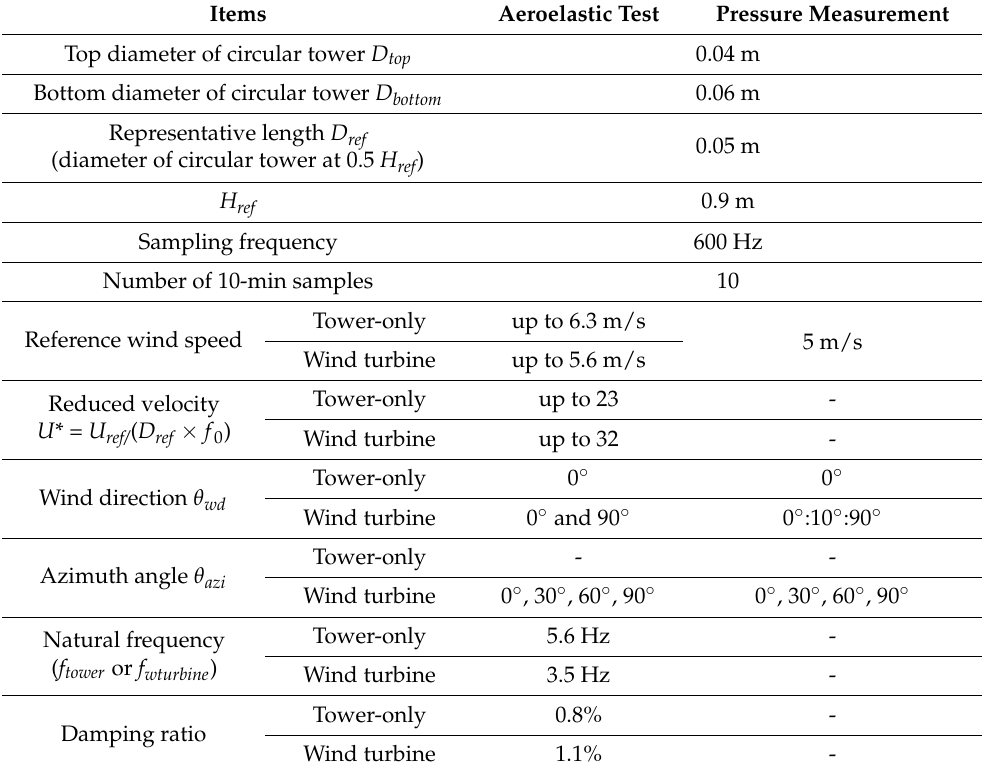
Table 2. Details of wind tunnel